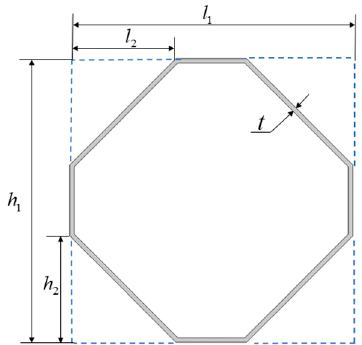
Figure 4. Parameters of octagonal frame structure to be